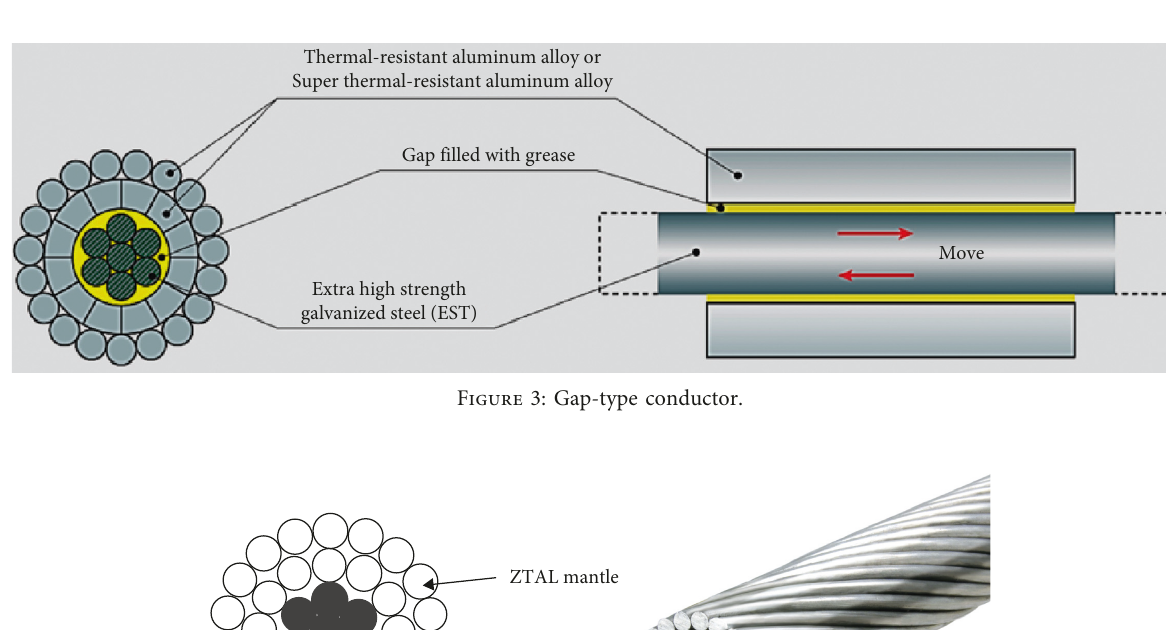
Figure 2: TACSR conductor.